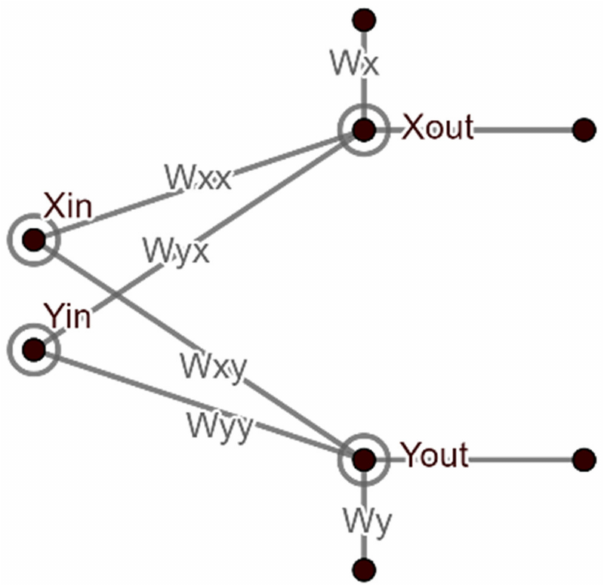
Figure 1. Neural Network for one function of